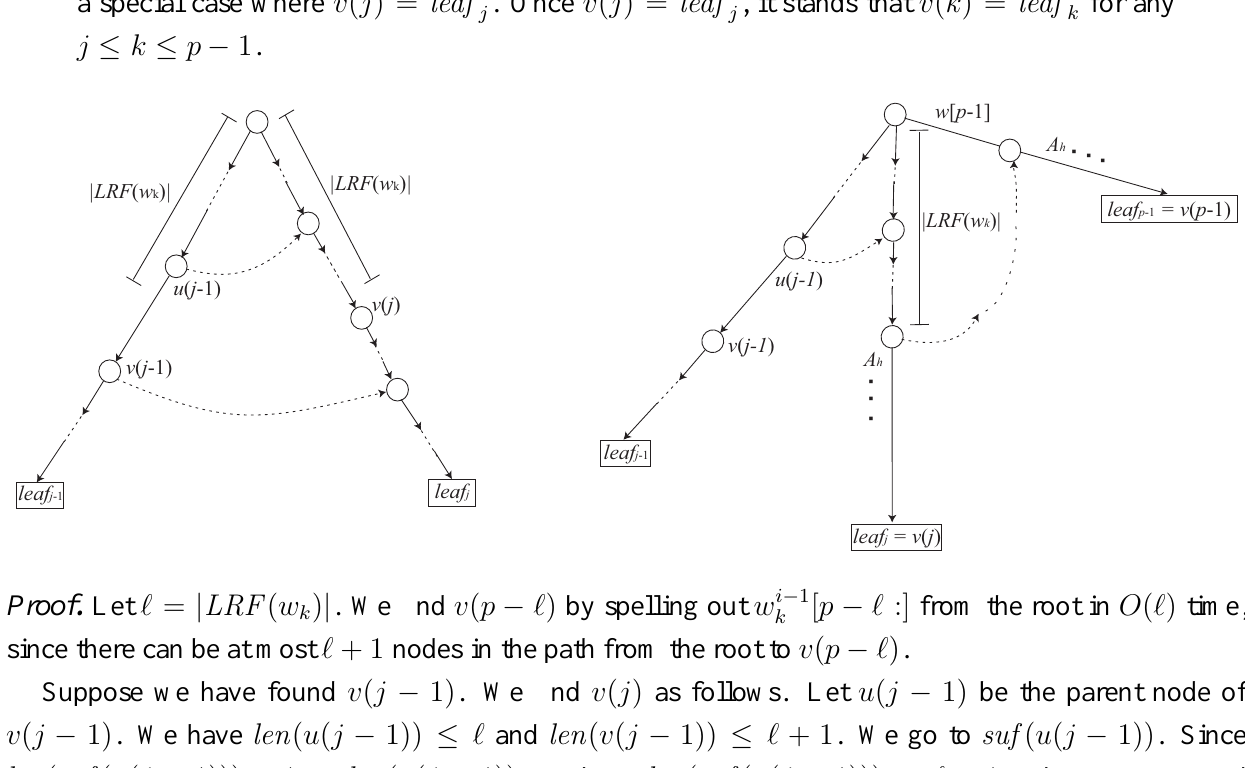
. Once v ( j ) = leaf , it stands that v ( k ) = leaf j j